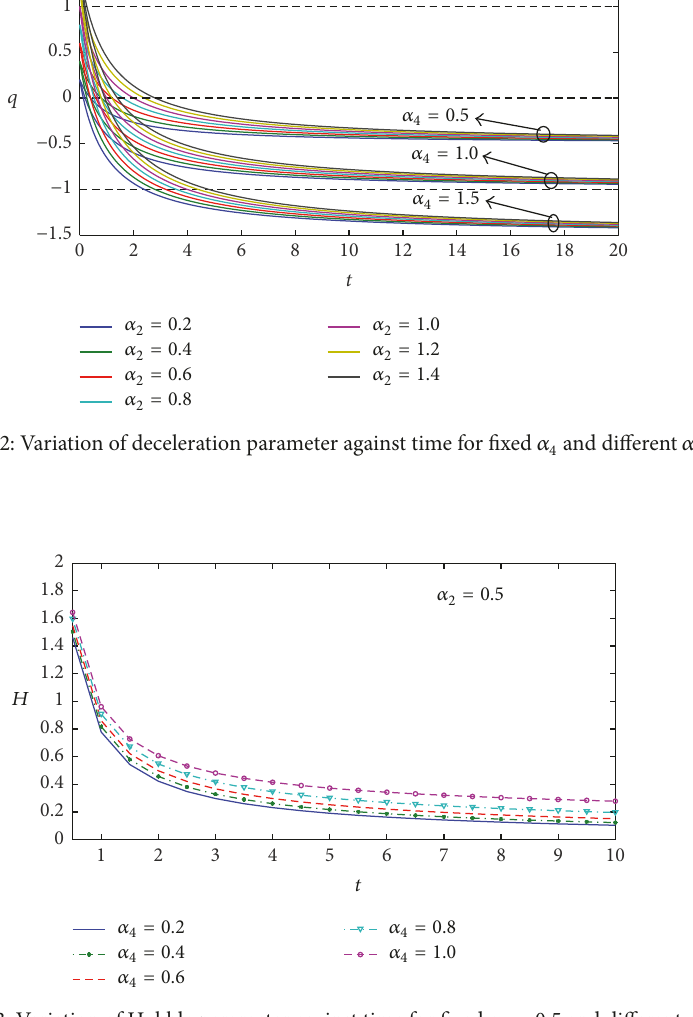
Figure 3: Variation of Hubble parameter against time for fixed 𝛼 2 = 0.5 and different 𝛼 4 .